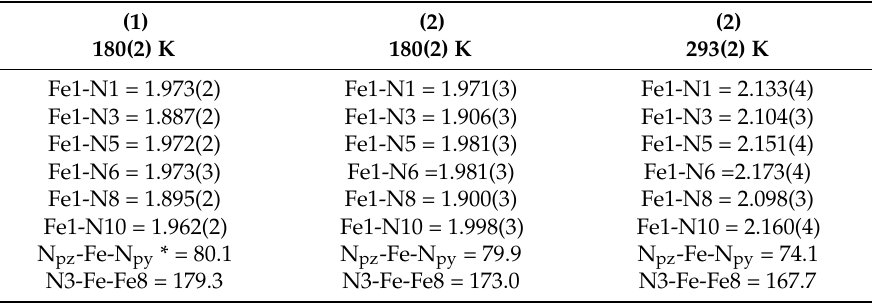
Table 2. Fe-N bond distances (in Å) for ( 1 ) and ( 2